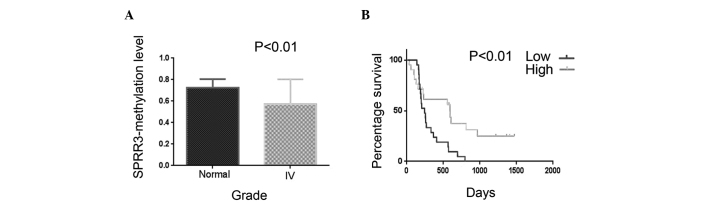
Methylation level of SPRR3 in gliomas and association with survival in glioblastoma multiforme. (A) Methylation levels of SPRR3 in healthy individuals and high-grade gliomas, analyzed by DNA methylation profiling containing 227 frozen glioma tissues. The methylation level of SPRR3 was significantly lower in high-grage glioma patients compared with those in healthy individuals (P<0.001). (B) Kaplan-Meier survival curves according to the methylation level of SPRR3 in 42 frozen high-grade glioma tissues. The log-rank test was used to calculate P-values. SPRR3, small proline-rich protein 3.